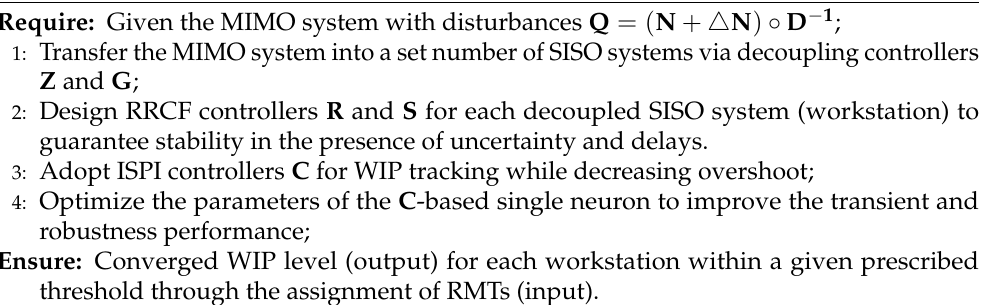
Algorithm 1 Framework of the adaptive